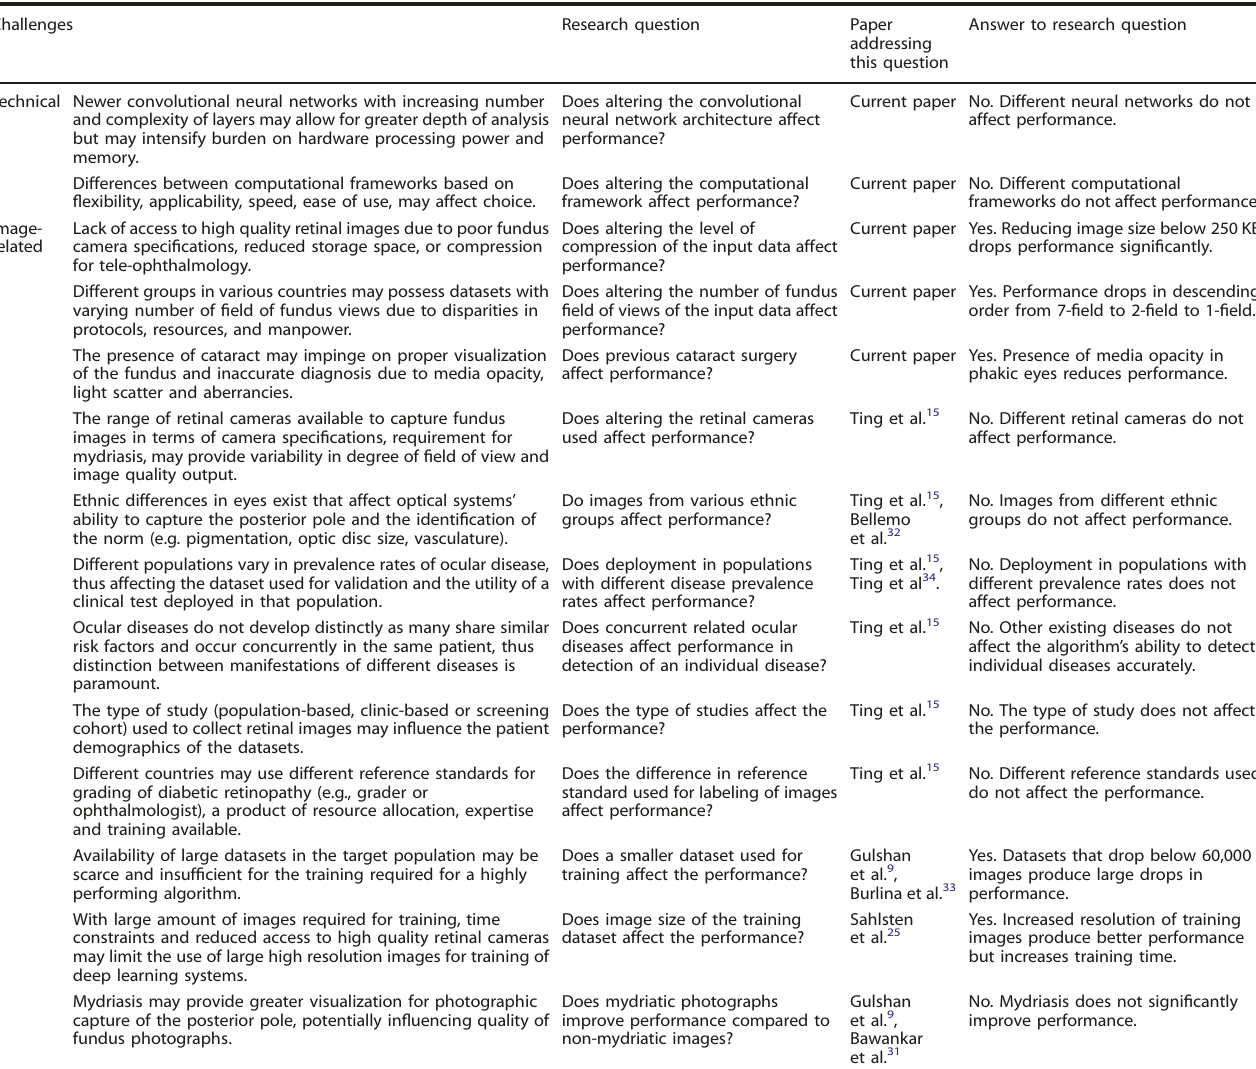
Table 1. Technical and image-related challenges to development of deep learning algorithms for ocular disease detection.